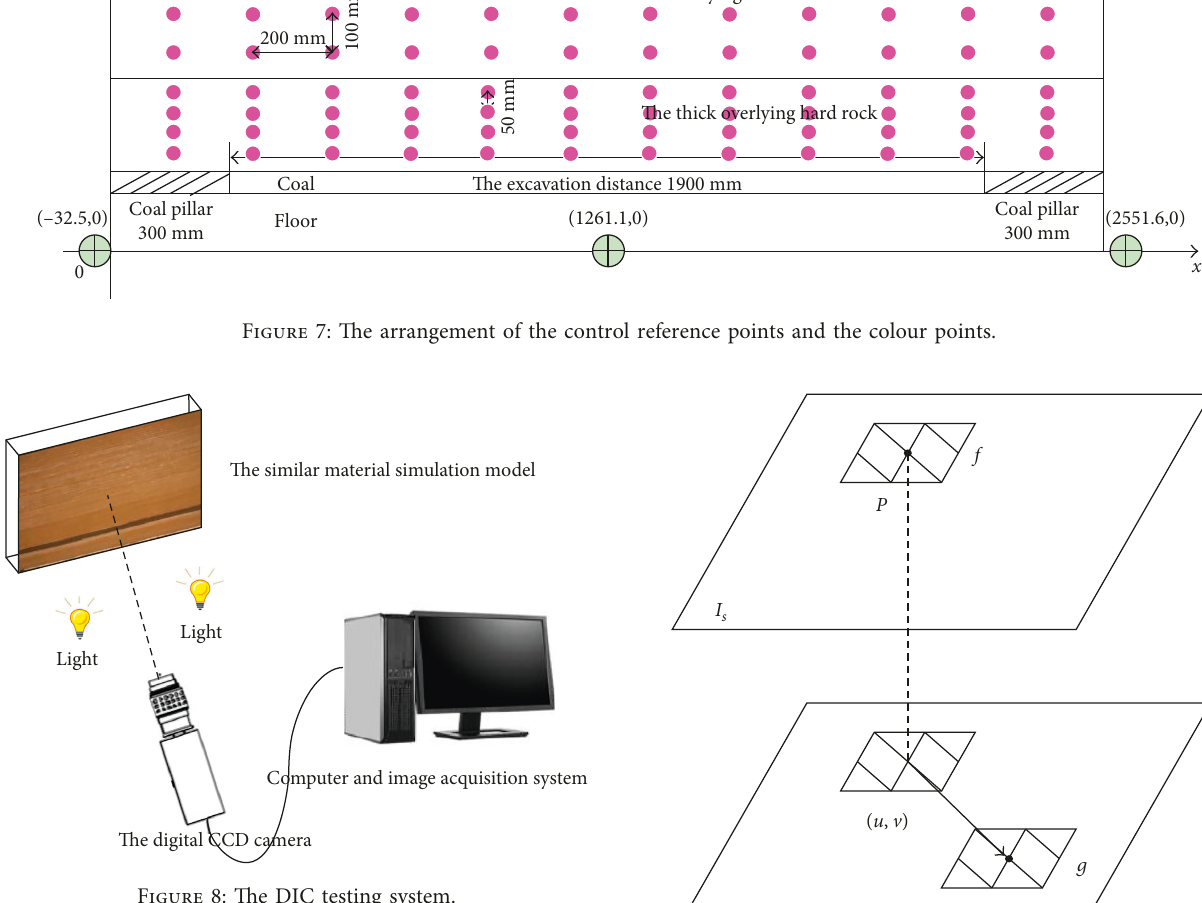
Figure 8: The DIC testing system.